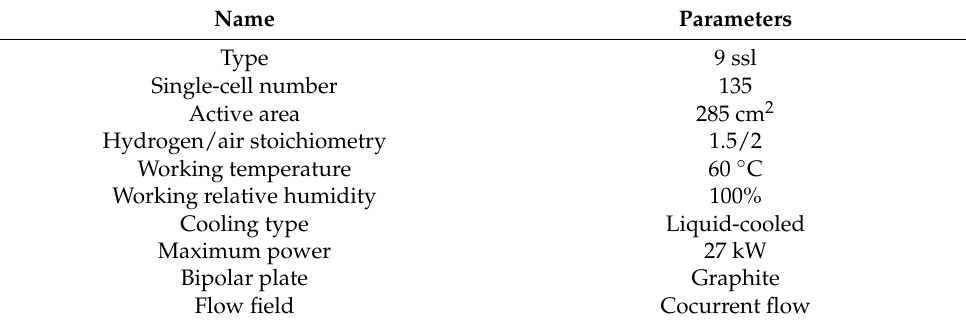
Table 1. The parameters of the PEMFC stack.